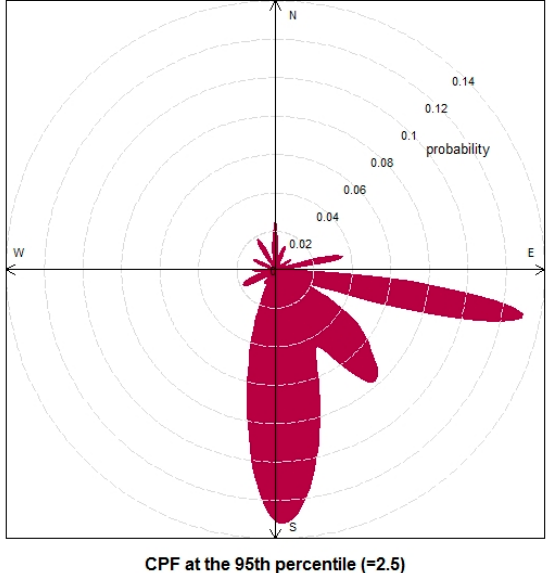
Figure 4. A CPF (conditional probability function) plot of eBC concentrations > 95th percentile (2.5 µg m − 3 ) using the entire sampling period.